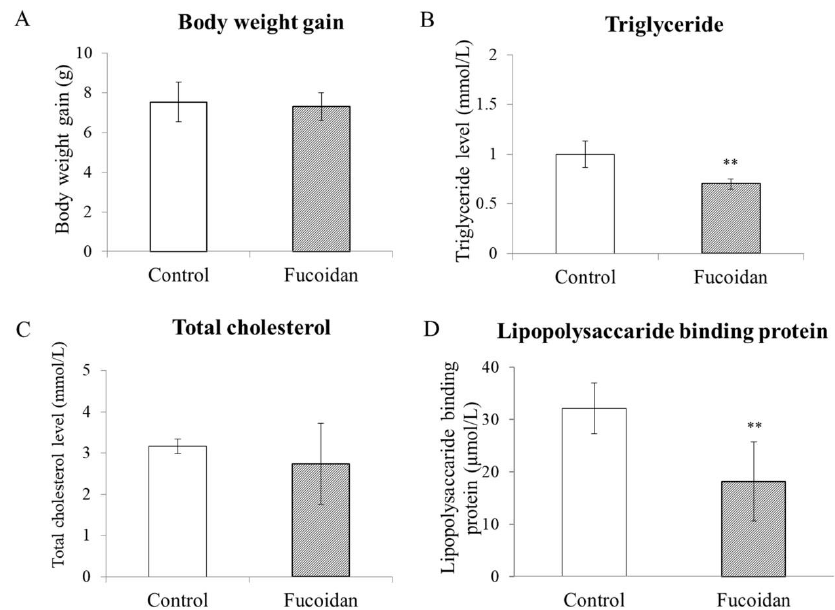
Figure A1. Effects of fucoidan supplementation in mice after 10 weeks on ( A ) body weight, ( B ) triglyceride, ( C ) total cholesterol, and ( D ) lipopolysaccharide-binding protein levels. ** p < 0.01. Blank square, control group; grey square, fu- coidan group.